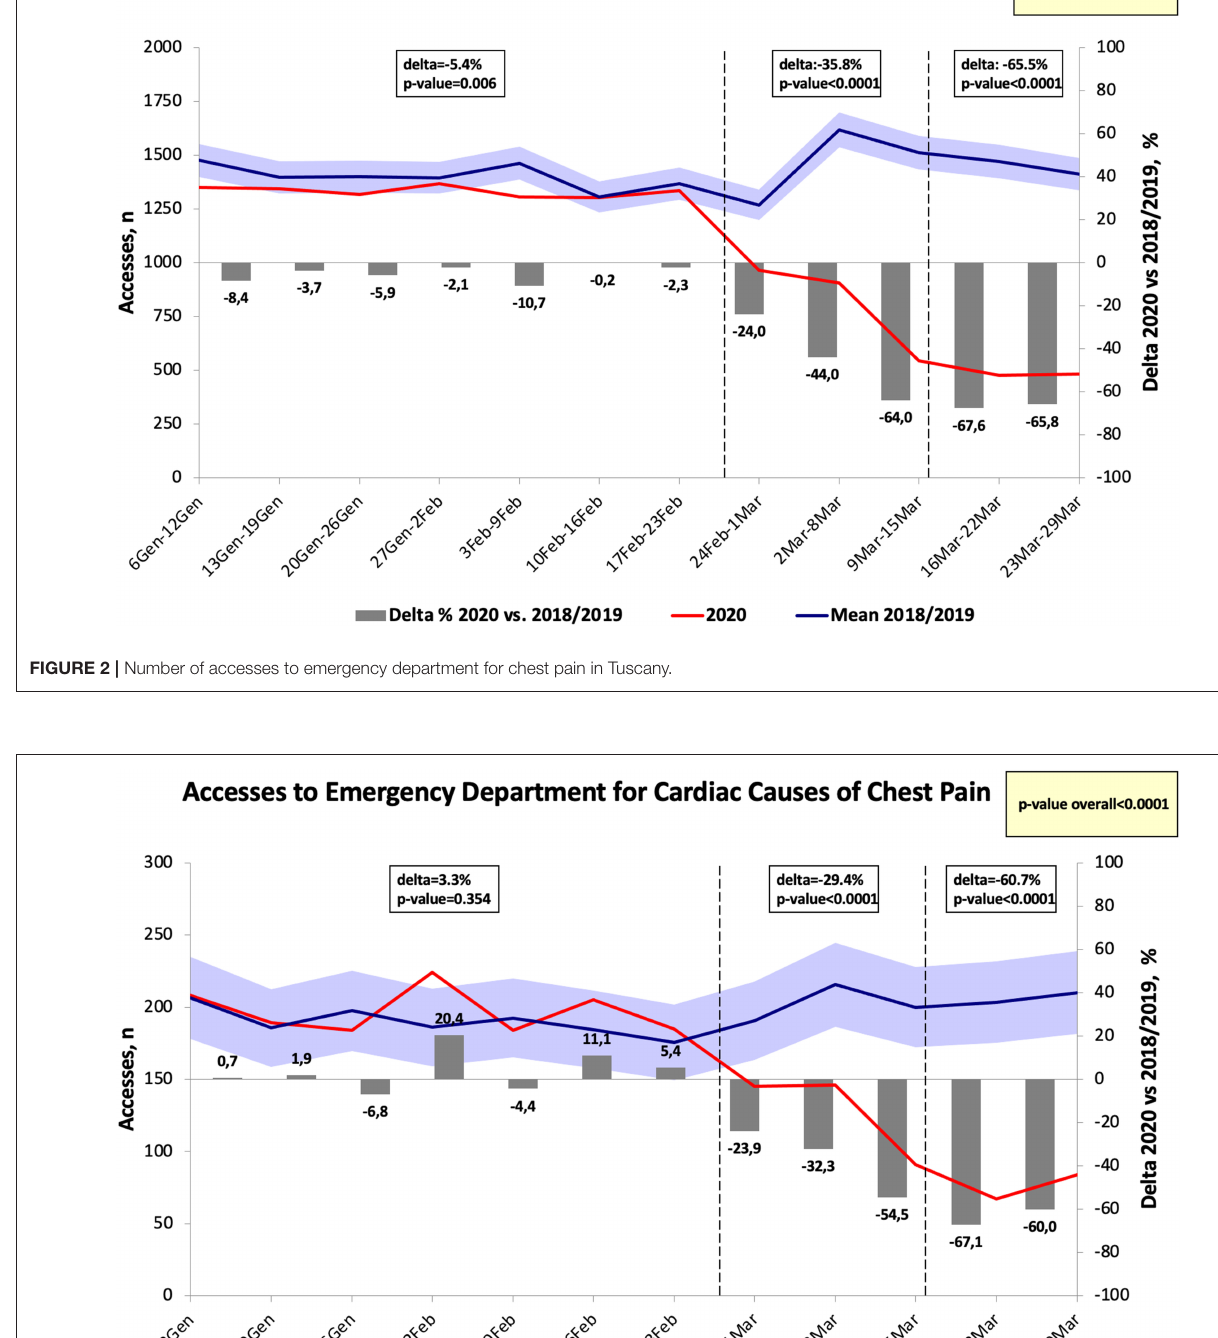
Frontiers in Cardiovascular Medicine | www.frontiersin.org